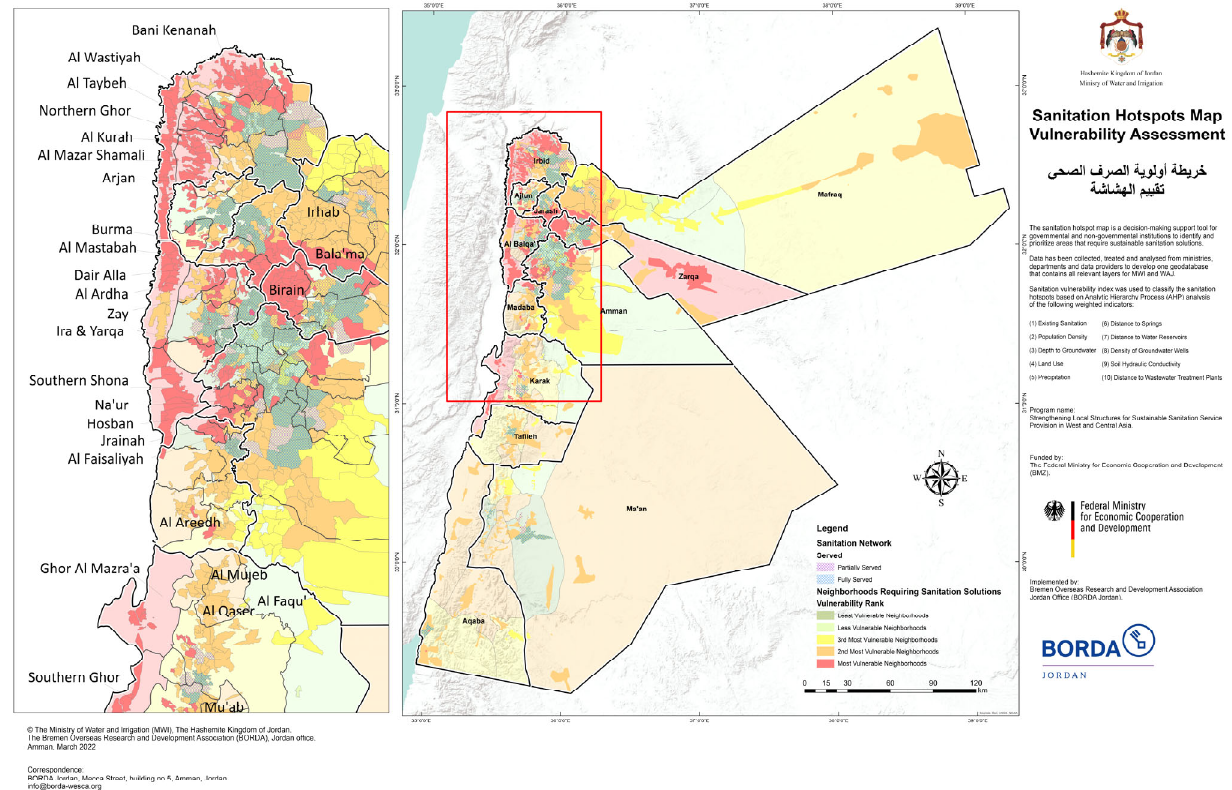
Figure 13. Final Sanitation Hotspots Map.